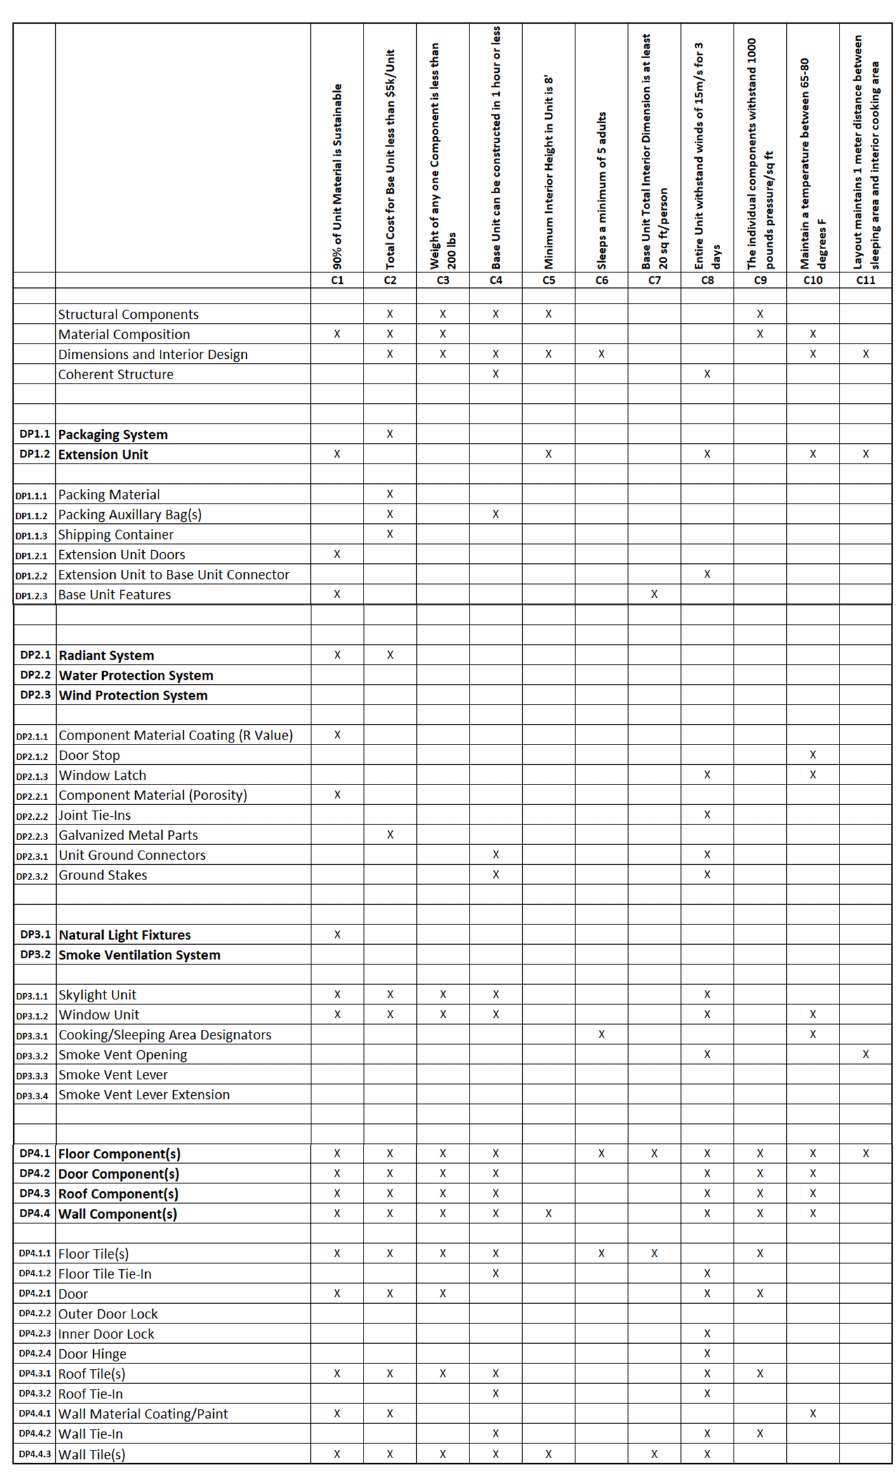
Figure 24. Constraint to Design Parameter (DP) Mapping for Axiomatic